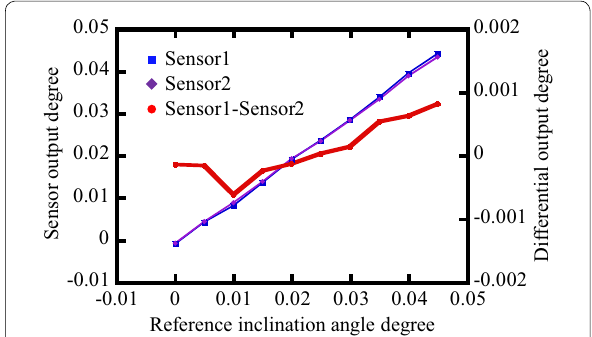
Figure 9 Sensor output as a function of inclination angle